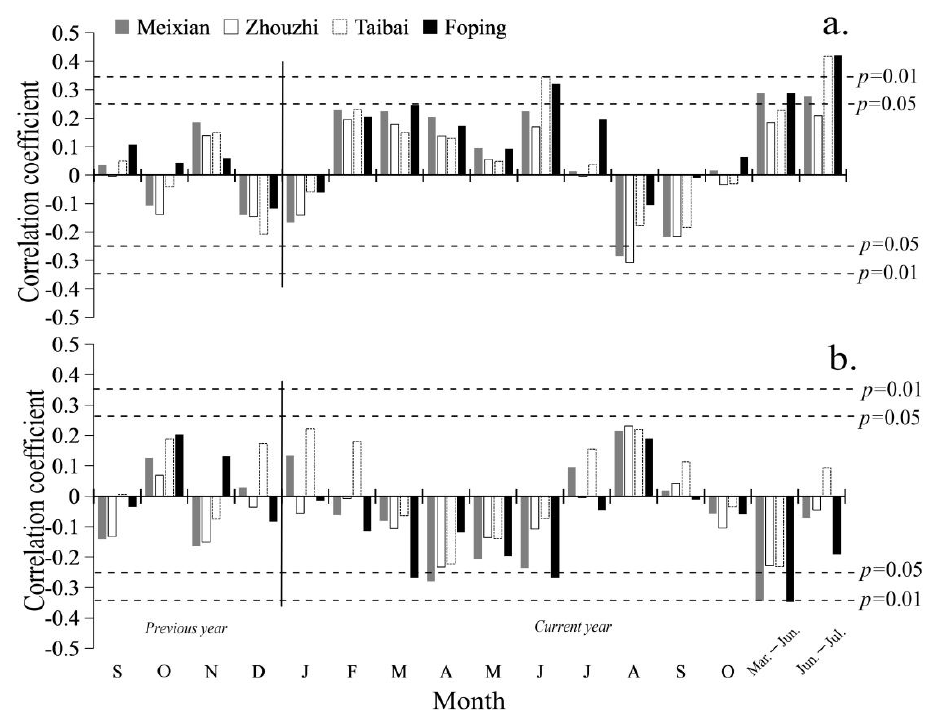
Figure 4. Correlation analysis between Larix chinensis tree ‐ ring width residual chronology (RES) and monthly mean temperature ( a ) and total precipitation ( b ) from the Meixian, Zhouzhi, Taibai and Foping stations during 1959 – 2013.